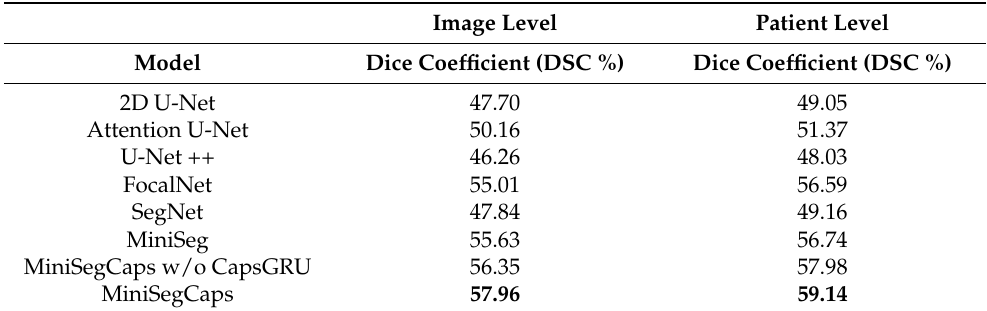
Table 4. Comparison of the image-level and patient-level performance between our method and baseline methods in benign nodule segmentation (e.g., BPH).